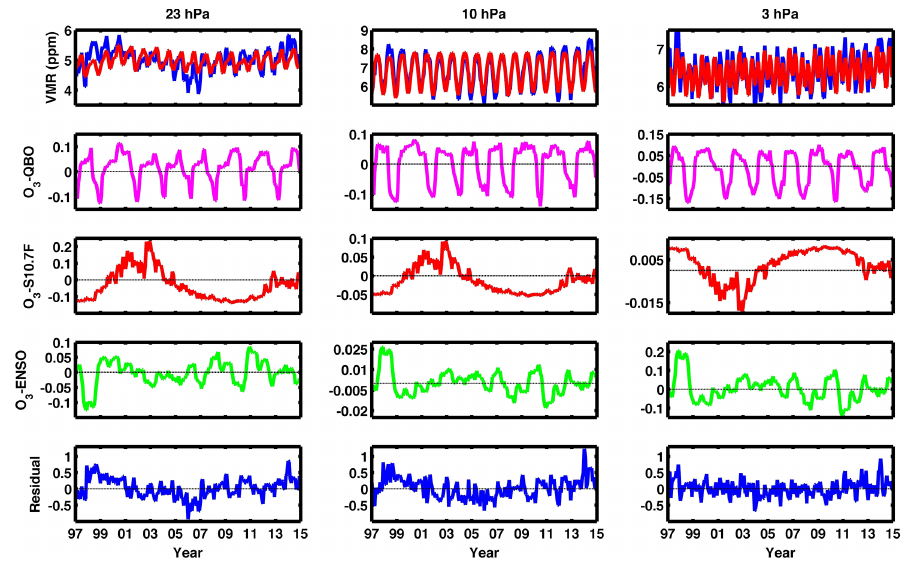
Figure 1. In the first panel of each column the GROMOS monthly means in blue and the calculated fit in red is represented. Every column represents a different pressure level, representative of the lower, middle and upper stratosphere (23, 10 and 3hPa respectively). In the second, third and fourth panel of each column the ozone fitted signals of the proxies QBO (magenta line), solar F10.7cm flux (red line) and ENSO (green line) are shown. The last panel of every column shows the